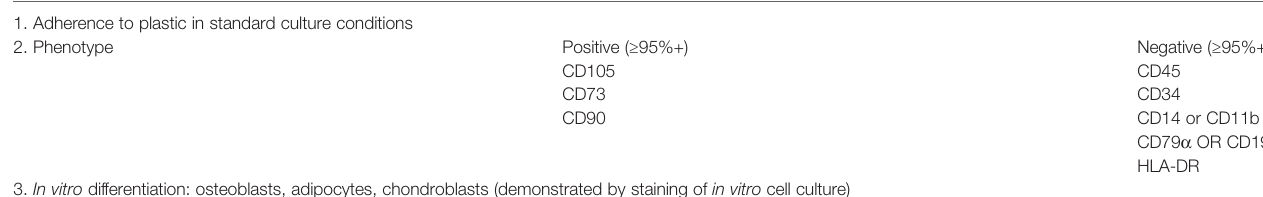
TABLE 1 | Minimal criteria for de fi ning MSCs according to the